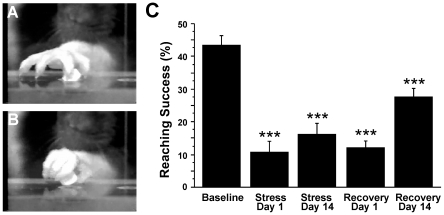
Skilled reaching performance in male rats.A, B: Series of photographs illustrating forelimb and digit movements of a rat grasping a food pellet. C: skilled reaching success in rats before (baseline), during and after two weeks of stress (mean ± SEM). Note that stress diminished skilled reaching performance after acute (day 1) and chronic (day 14) of daily stress treatment. Reaching success did not return to baseline levels within 14 days of recovery. Asterisks represent statistical significance (*** p<0.001).